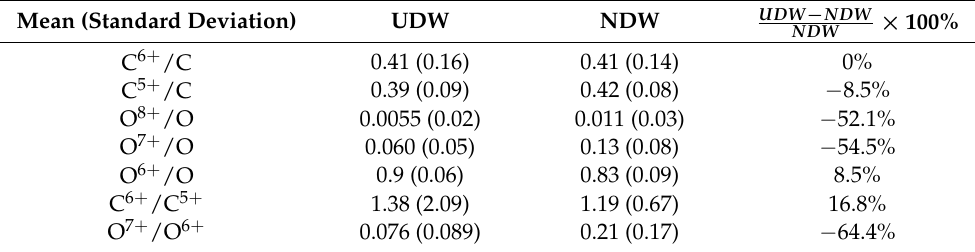
Table 2. Averages, standard deviations, and changing rates of the C 6 + /C, C 5 + /C, O 8 + /O, O 7 + /O, O 6 + /O, O 7 + /O 6 + and C 6 + /C 5 + ratios of the UDW and NDW measurements from ACE/SWICS during